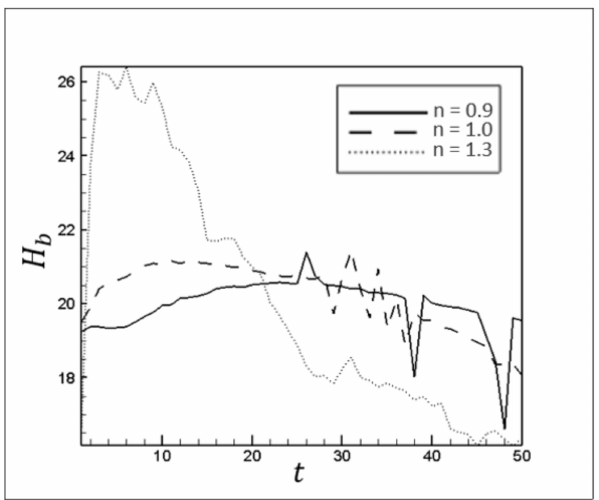
Figure 17. The mean thickness of the static layer at the bottom of the channel, H b , over time for different